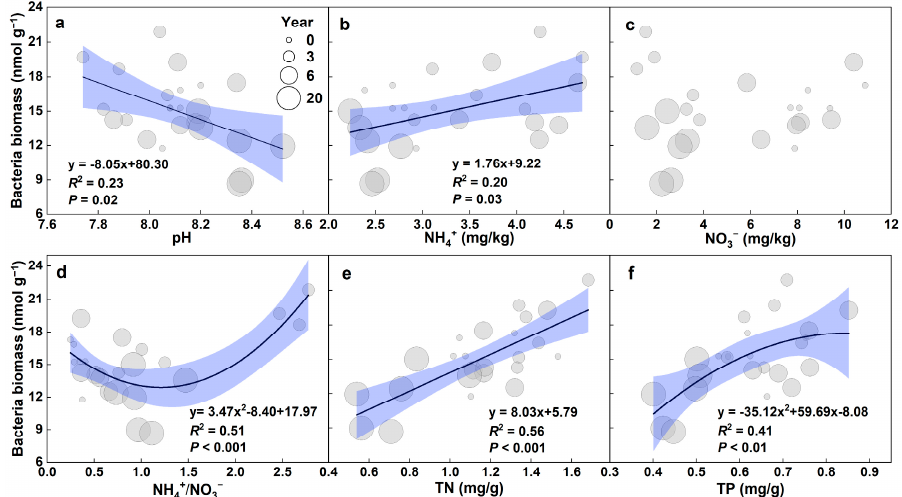
Figure 4. Relationships of bacteria biomass (nmol·g − 1 ) with soil properties (pH, ( a ); NH 4+ , ( b ); NO 3 − , ( c ); NH 4+ /NO 3 − , ( d ); TN, ( e ); TP, ( f )). See abbreviations in Table 2.